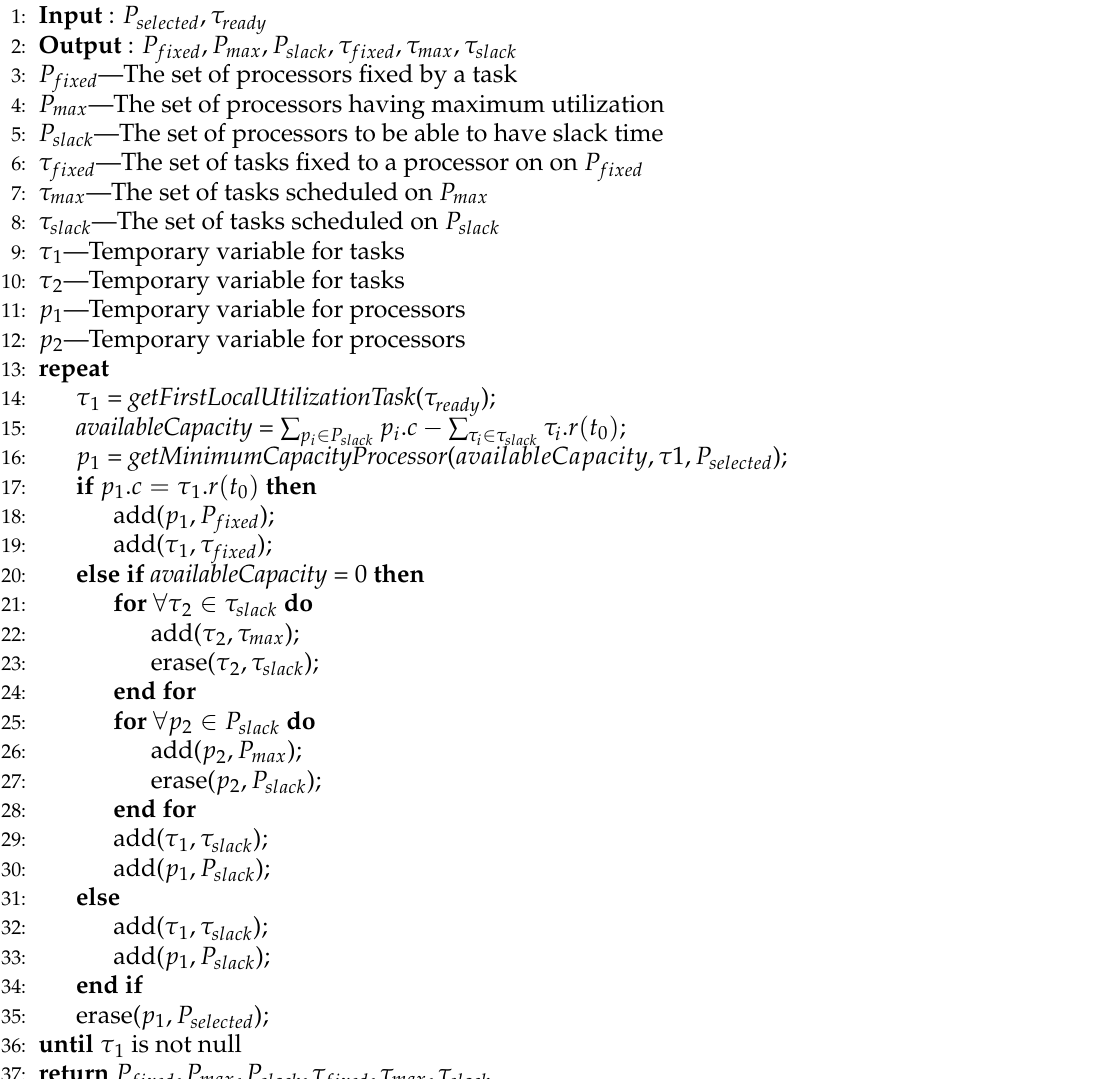
Algorithm 2 Classification of selected processors for